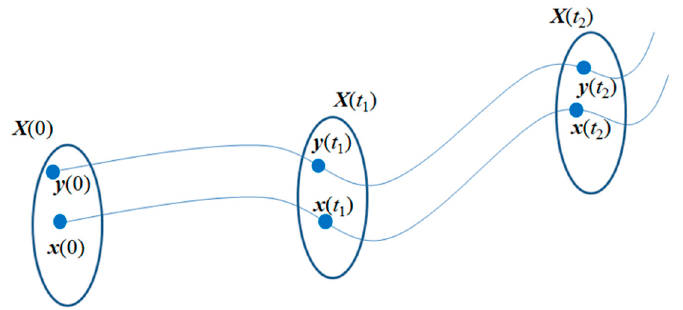
Figure 3. Phase portrait system.